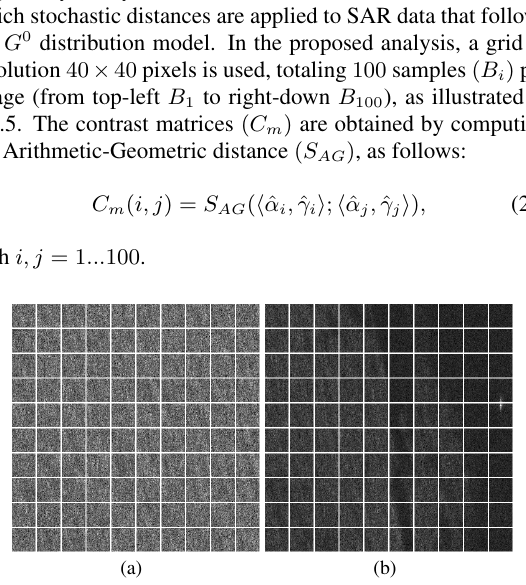
Figure 5. Grid used to compute the contrast matrices of the SAR images in Fig.4(a) and Fig.4(b).